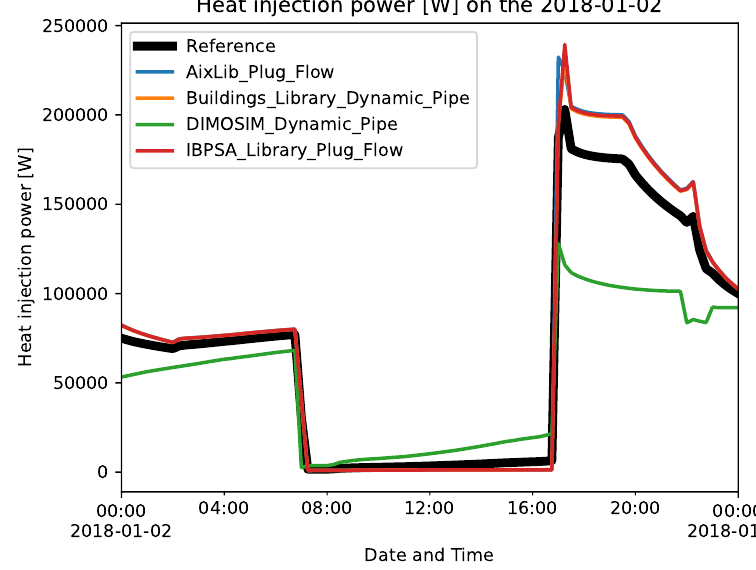
Figure 8. Heat injection comparison between different simulation models at a exemplary winter day, calculated with the DESTEST result comparison